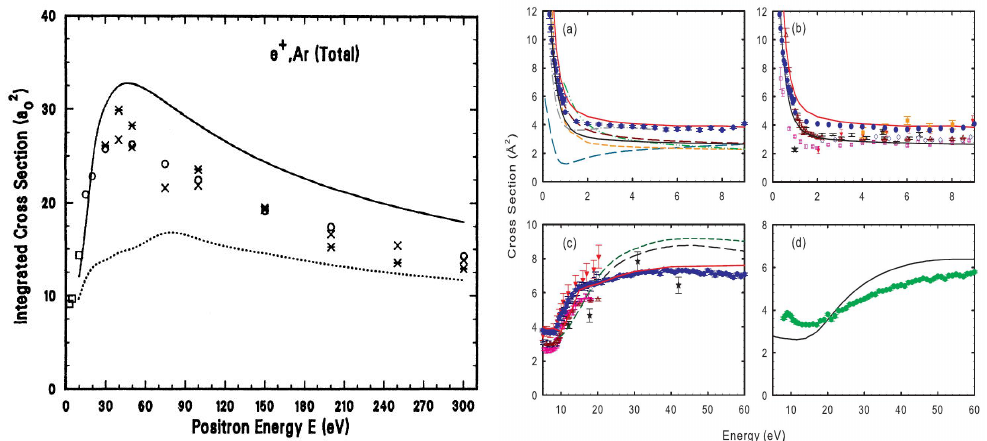
Figure 5. Left : Comparison of total integrated cross sections for scattering of positrons from Ar at various energies between the theory using optical potential [9] and 4 experiments—open squares [21], open circles [25], asterisks [28], and cross [29]. The solid curve corresponds to use of absorption potential of Reference [188] and dotted curve to version 3 potential of Reference [189]. Although sold curve shows agreement in the low energy cross sections the rest of the measured integrated cross sections remain in-between the two predictions. Right : Total integrated cross sections for scattering of positrons from Ar at various energies by Jones et al. [26]: ( a ) Measured grand total cross section ( σ GT ) (filled circles) below the ionization threshold for positronium formation (E Ps are compared with various theoretical approximations, ( b ) Measured σ GT is compared with other experiments, ( c ) Measured σ GT above (E Ps are compared with other measured values and theories, ( d ) Measured cross section σ GT − Ps where cross section for positronium has been subtracted above (E Ps are compared with their ROP